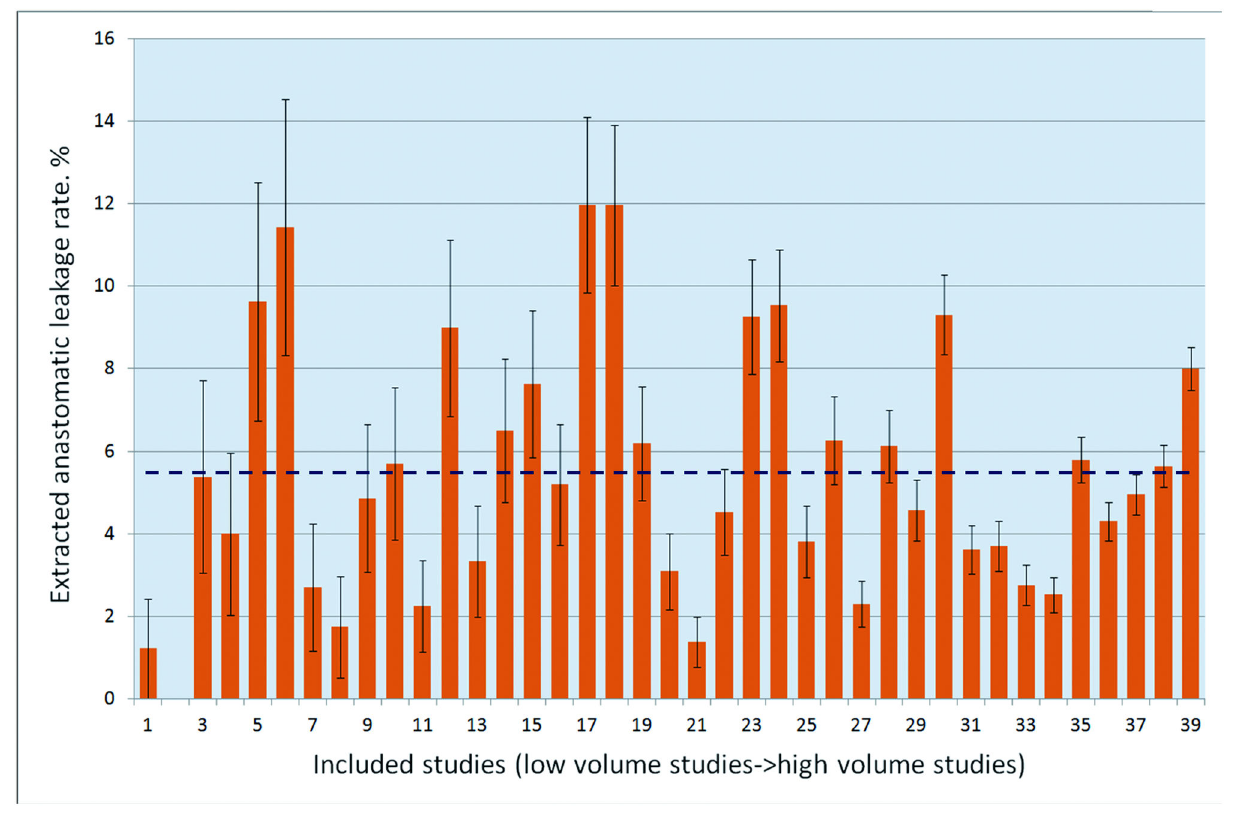
Figure 5. Extracted rates of Grade C leakage ranked by